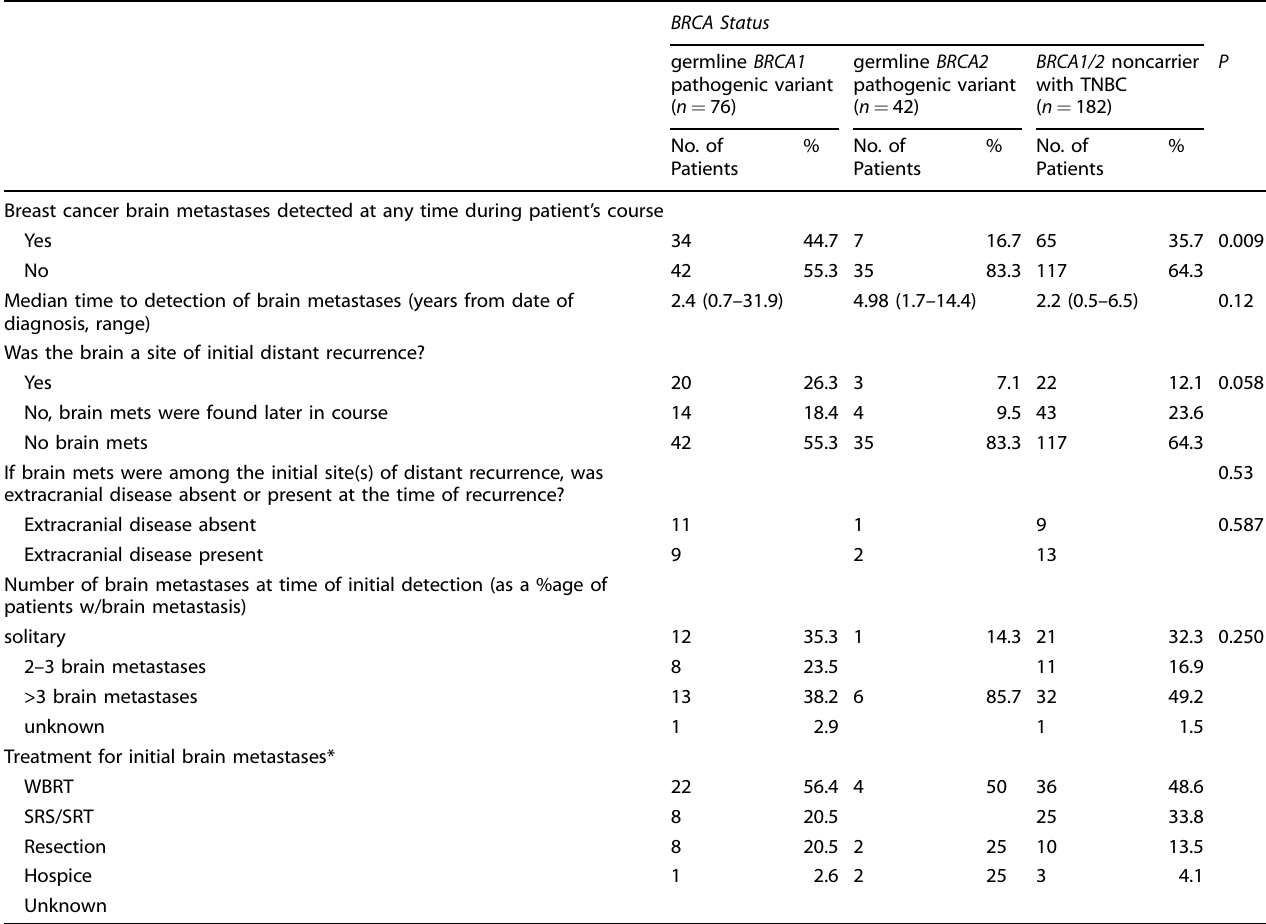
Table 3. Characteristics of brain metastases in patients with distantly recurrent breast cancer by germline BRCA status.